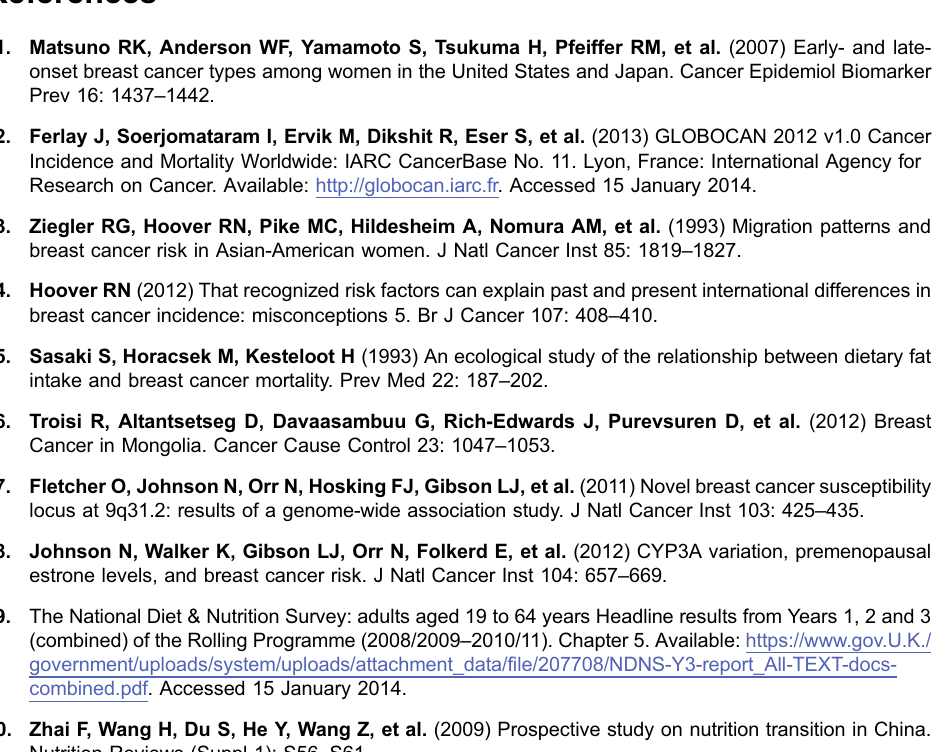
S2 Table. Hormone concentrations in women living in Ulaanbaatar, Mongolia and London,